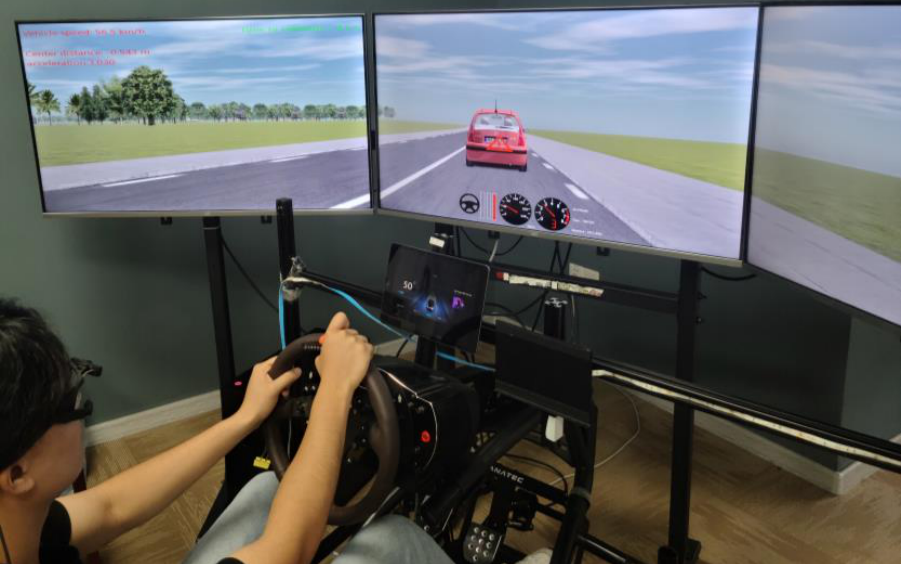
Figure 2. The open-cab driving simulator.